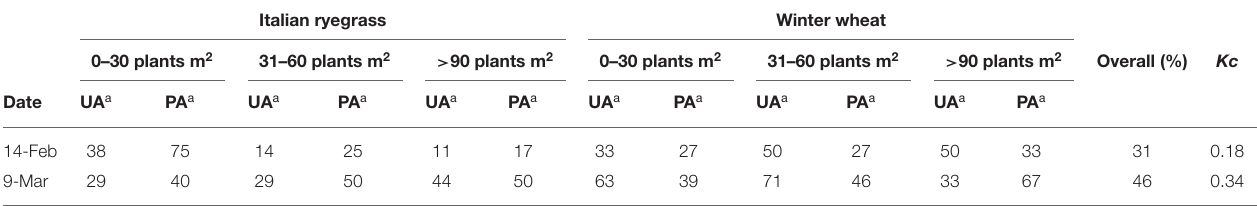
TABLE 2 | Summary of the 6-class supervised classification of discriminating between Italian ryegrass and winter wheat under different densities of each species with an unmanned aerial vehicle equipped with a multispectral sensor to acquire imagery flown at 15m.